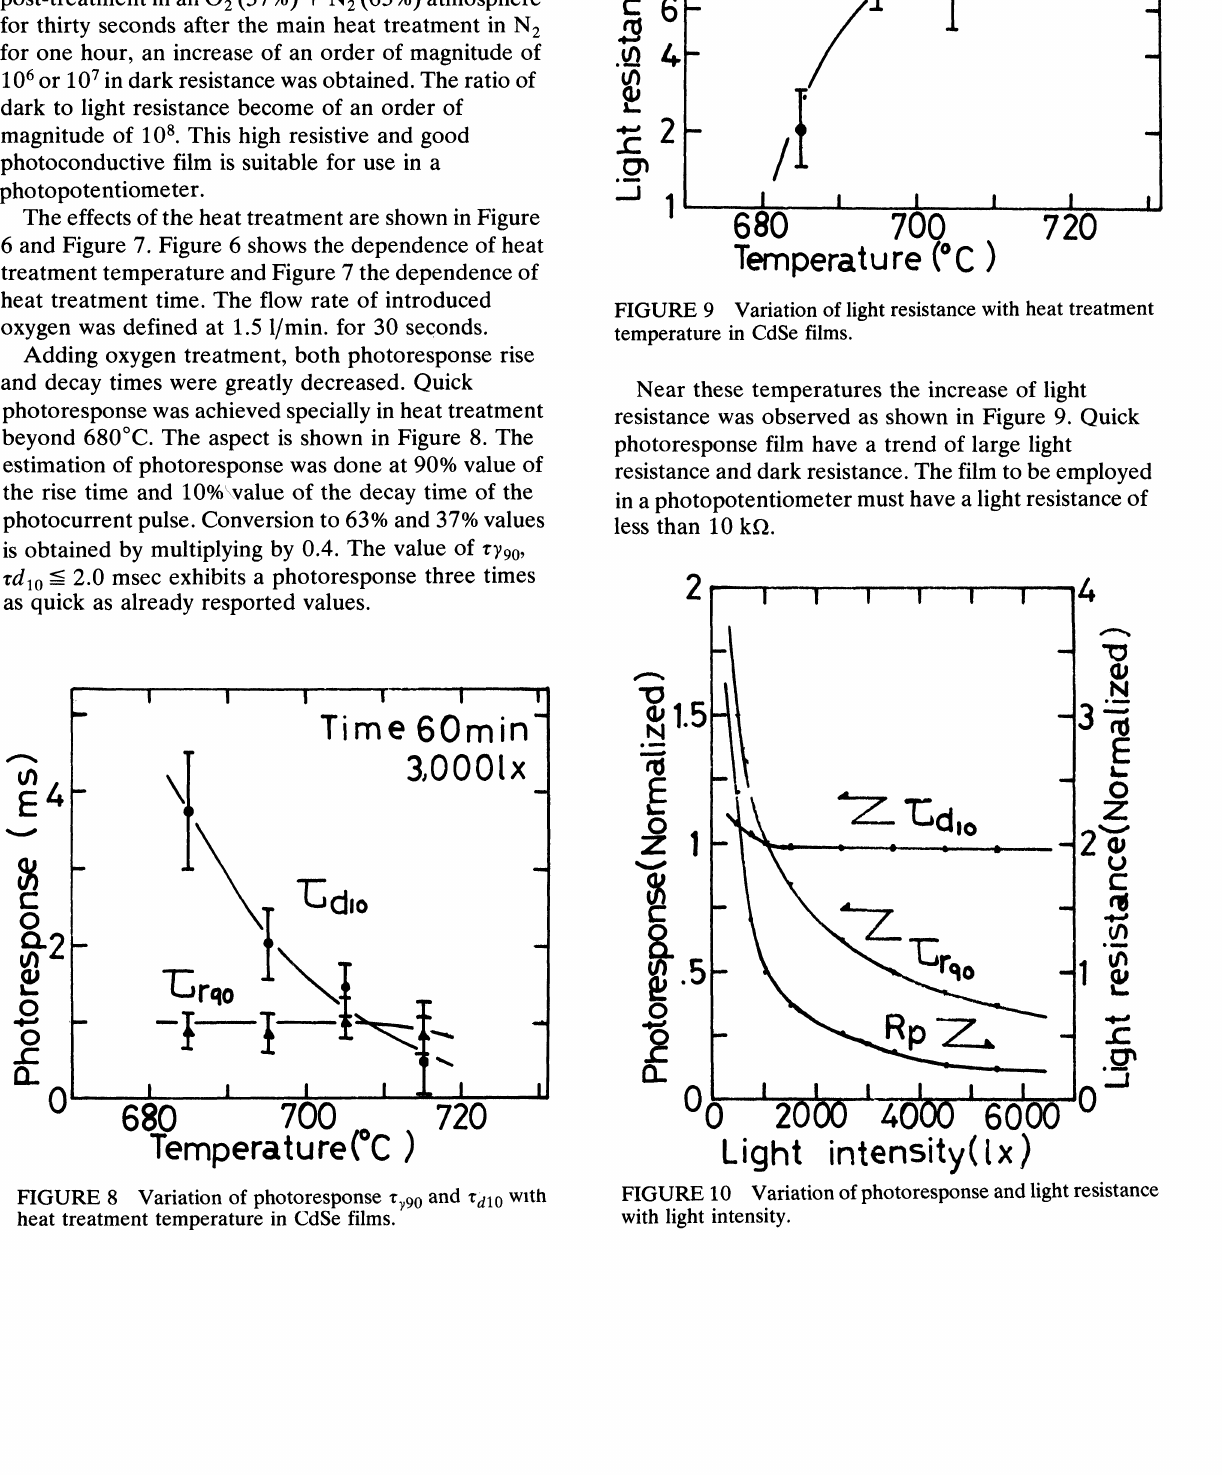
FIGURE 10 Variation of photoresponse and light resistance with light